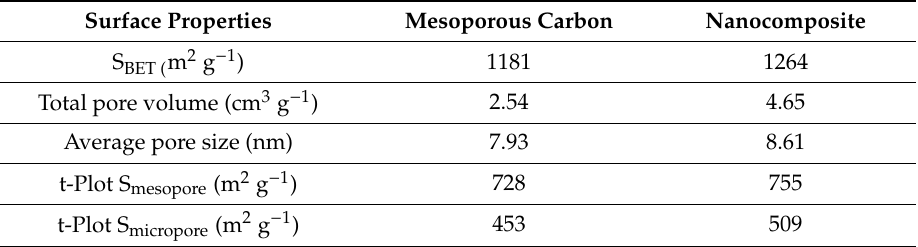
Table 2. Characteristics of adsorbent material; BET surface area; pore volume parameters of MPC and MMPC /